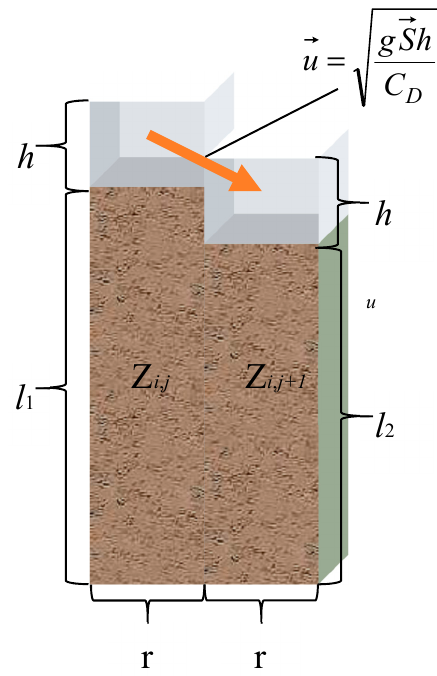
Figure 3. Schematic diagram of velocity and direction of adjacent cells.